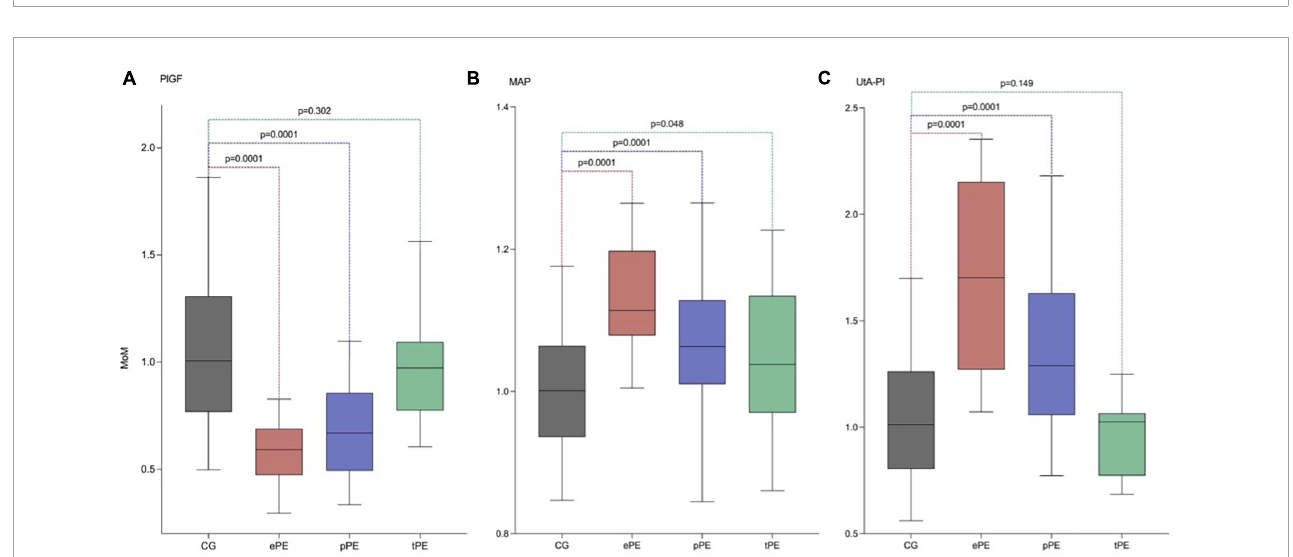
FIGURE3 Adjusted median, p5, and p95 of PlGF, MAP, and UtA-PI in the control group (CG), early preeclampsia (ePE), preterm preeclampsia (pPE), and term preeclampsia (tPE) using our model of maternal characteristics and medical history. (A) Serum placental growth factor (PlGF). (B) Values of MoM of the mean arterial pressure (MAP). (C) Values of MoM of the uterine artery pulsatility index